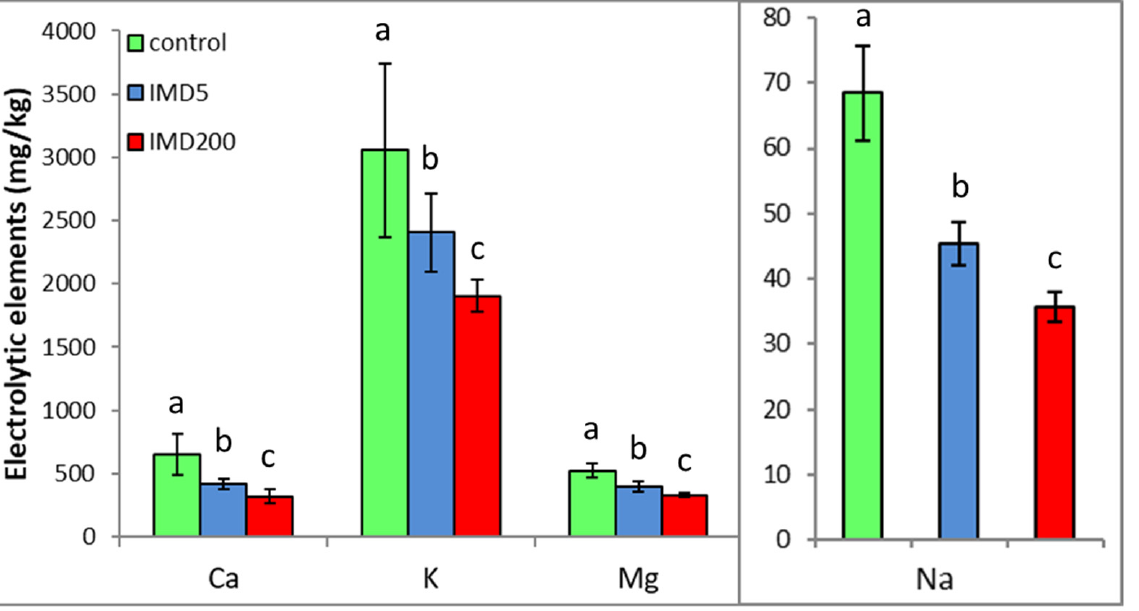
Figure 3. Body levels (mean ± SD) of the electrolytic bioelements in honey bee workers exposed and unexposed to imidacloprid. Explanations: control = bees were fed a diet without imidacloprid; IMD5 = bees were fed a diet containing a 5 ppb addition of imidacloprid; IMD200 = bees were fed a diet with a 200 ppb addition of imidacloprid. Different lowercase letters = differences between the means nested within each bioelement are significant (ANOVA + LSD; p < 0.05).